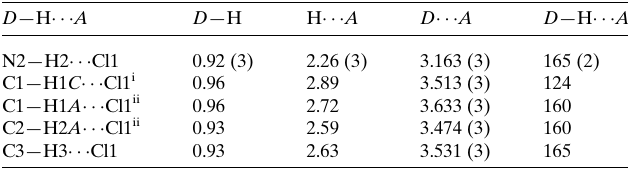
Table 1 Hydrogen-bond geometry (A˚ , (cid:4) ) for AmCl .